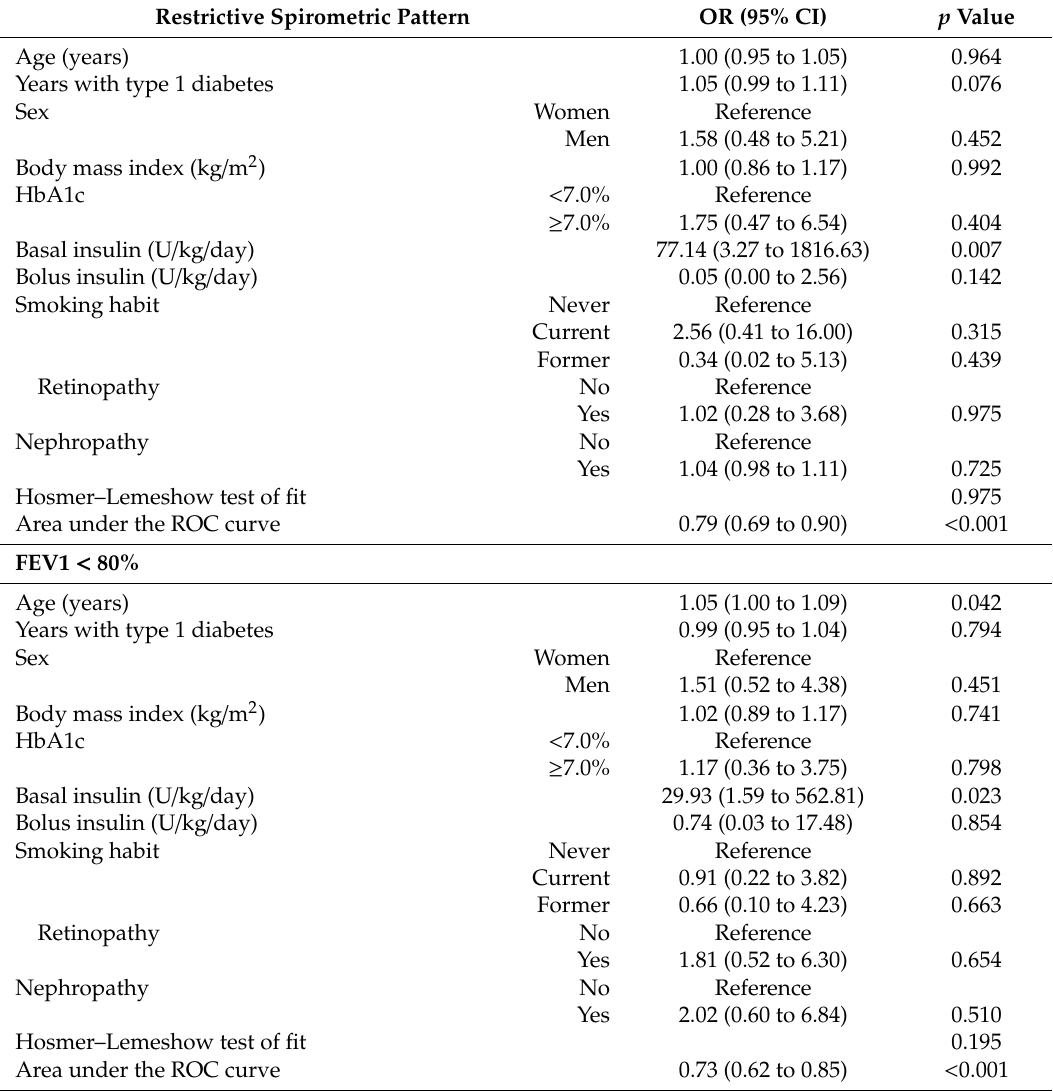
Table 5. A multivariable logistic regression model for the presence of a restrictive spirometric pattern and an abnormal ( < 80% of predicted) forced expiratory volume in the first second in patients with type 1